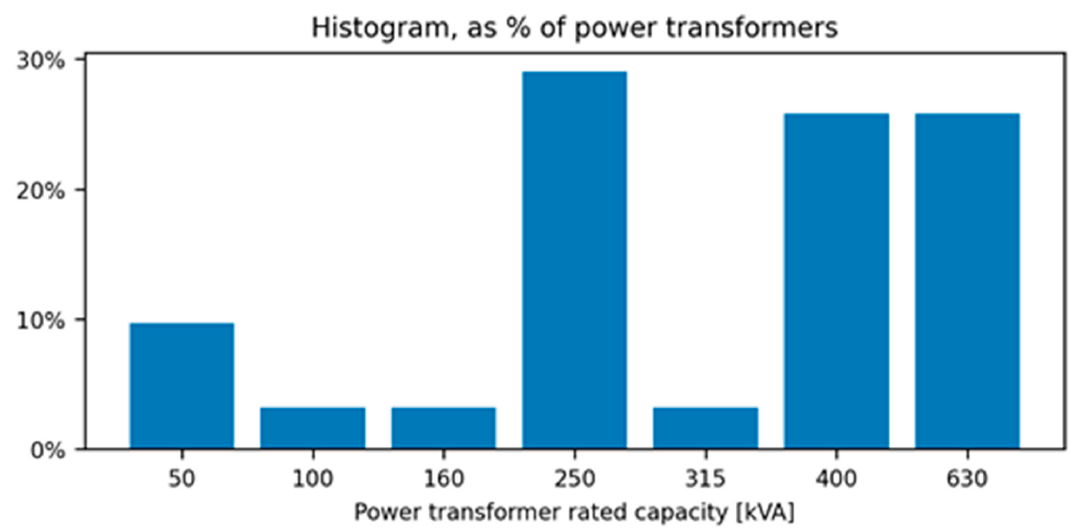
Figure 2. Rated capacity distribution of the power transformers installed in Reguengos de Monsaraz.